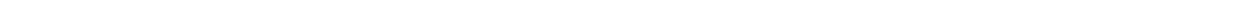
Figure 3 | Hypermutated tumours are enriched in NMD-elicit mutations targeting hypermutation-permissive pathways. ( a ) The barplot in the top panel shows the numbers of the different types of mutations ( y axis) in each sample ( x axis). The heatmap in the bottom panel shows the cancer type (cancer), whether a sample is hypermutated or not (hypermutation), log 10 of total mutation numbers (log 10 mutation frequency), whether a sample is microsatellite-stable or not (microsatellite stability), the NMD-elicit mutations in individual relevant genes and their pathway affiliation as indicated and the pathways affected by NMD-elicit mutations (black means that the pathway has at least one gene harbouring NMD-elicit mutations) in each sample ( x axis). ( b ) In STAD, the heatmap shows the log 10 of total mutation numbers (first row), MSI (second row), the NMD-elicit mutations in individual relevant genes (3rd–7th rows) and NMD-elicit mutations in genes that belong to certain pathways (8th–10th rows) in each sample ( x axis). FS, frameshift indels; IF, in-frame indels; SN, single-nucleotide substitution mutations. ( c ) In gastric cancer validation cohort 13 , the heatmap in the bottom panel shows the log 10 of total mutation numbers (first row), MSI (second row), the NMD-elicit mutations in individual relevant genes (3rd–7th rows) and NMD-elicit mutations in genes that belong to certain pathways (8th–10th rows) in each sample ( x axis). FS, frameshift indels; IF, in-frame indels; SN, single-nucleotide mutations. Del, deletions; Ins, insertion; SN, substitution mutations. Note that the NMD-escape mutations in EIF5B and LARP4B are likely to induce NMD as they failed the NMD rules only marginally. Both EIF5B NMD-escape mutations failed the rules because they generate PTCs that are 175bp away from the start codon. The LARP4B mutations generate a PTC that is 187bp away from the start